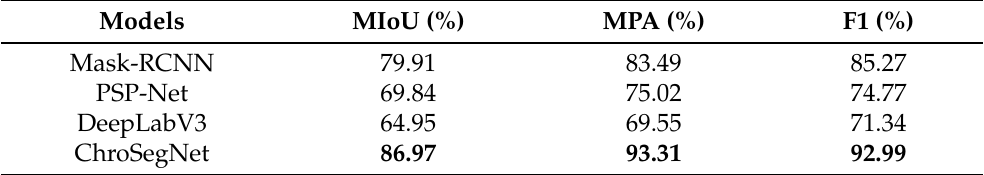
Table 3. Segmentation performance analysis of different segmentation models with ChroSegNet.